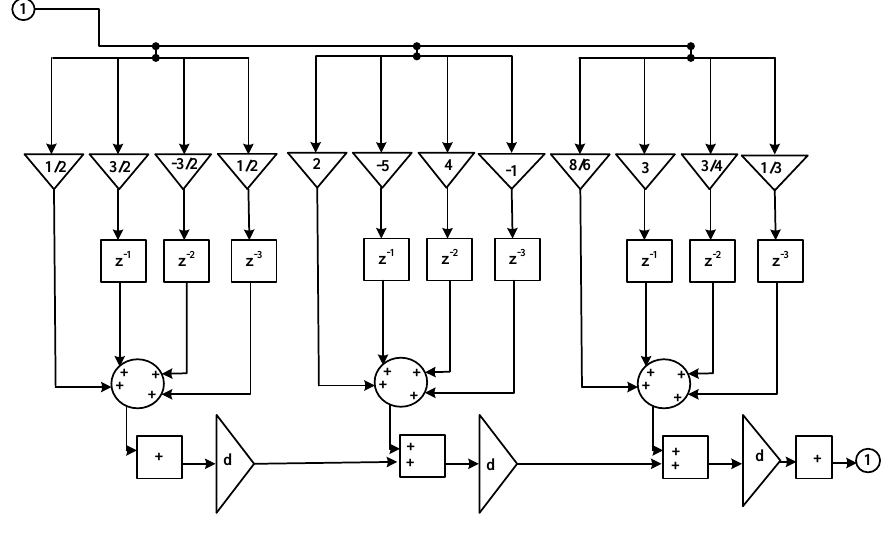
Figure 2. Farrow